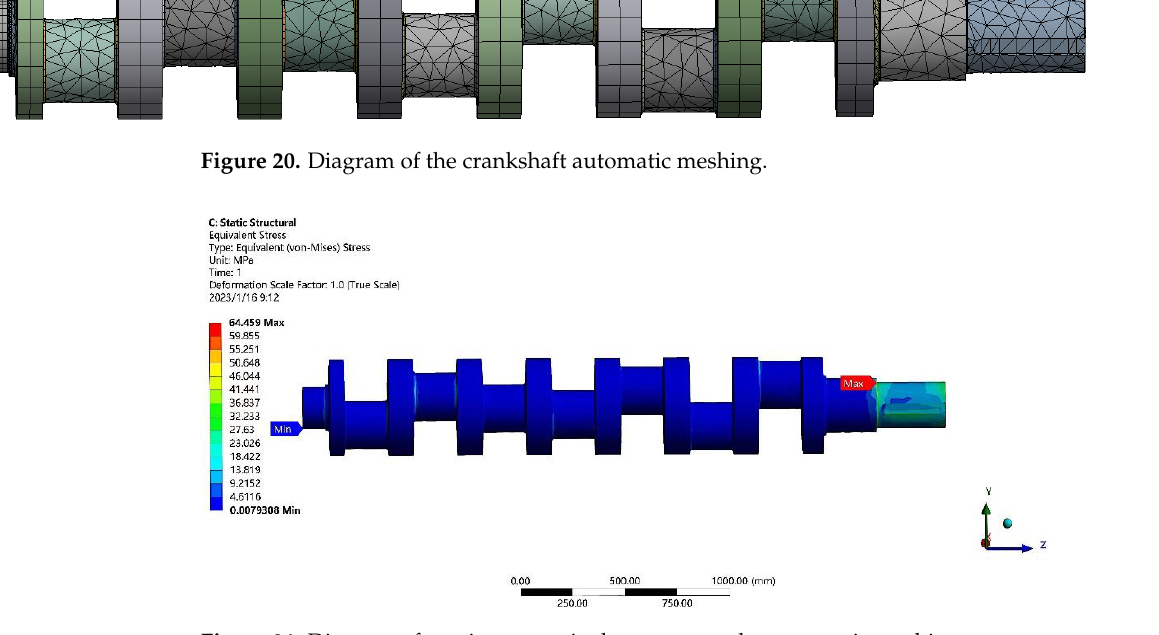
Figure 21. Diagram of maximum equivalent stress under automatic meshing .